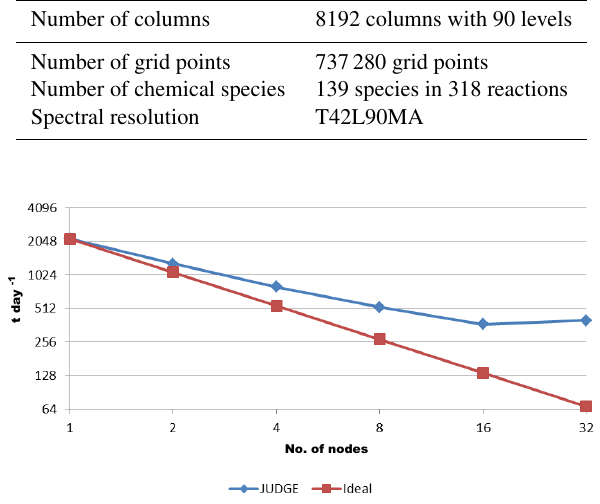
Figure 3. Wall time for 1 simulated day vs. the number of nodes on